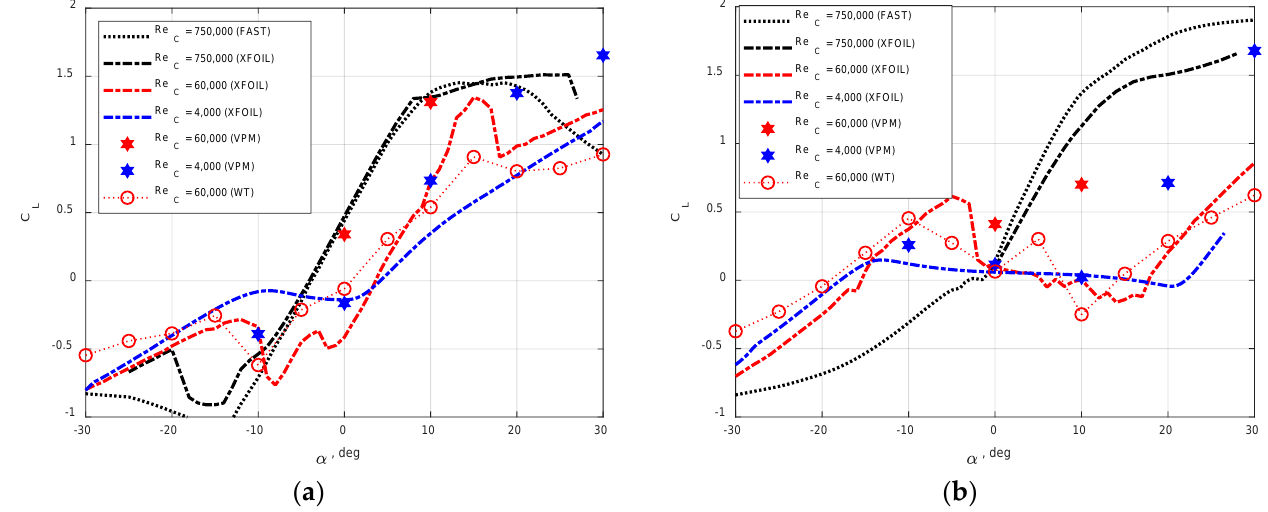
Figure 15. Time-averaged lift coefficients: ( a ) NACA64 and ( b ) DU40.